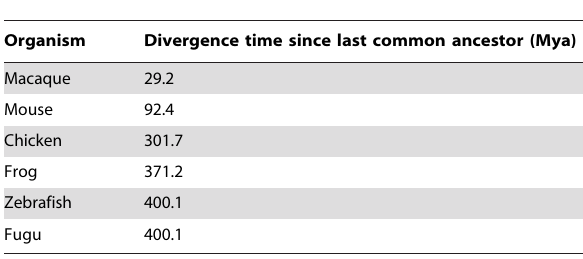
Table 1. Divergence time since last common